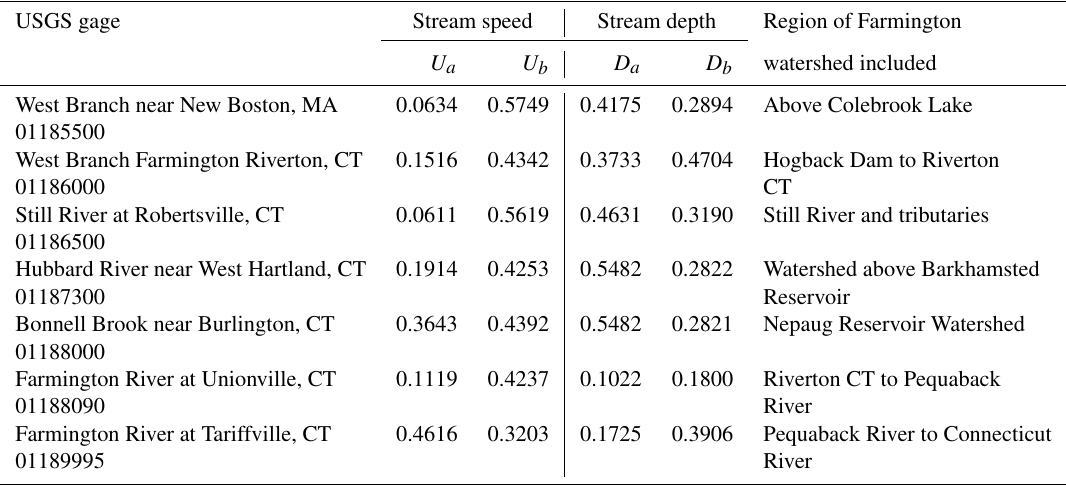
Table 3. Parameters for stream speed and depth in Eqs. (S7) and (S8) (see Supplement) estimated from rating measurements at USGS gages in the Farmington River basin. Coefficients from individual USGS gages are extended to other river segments as